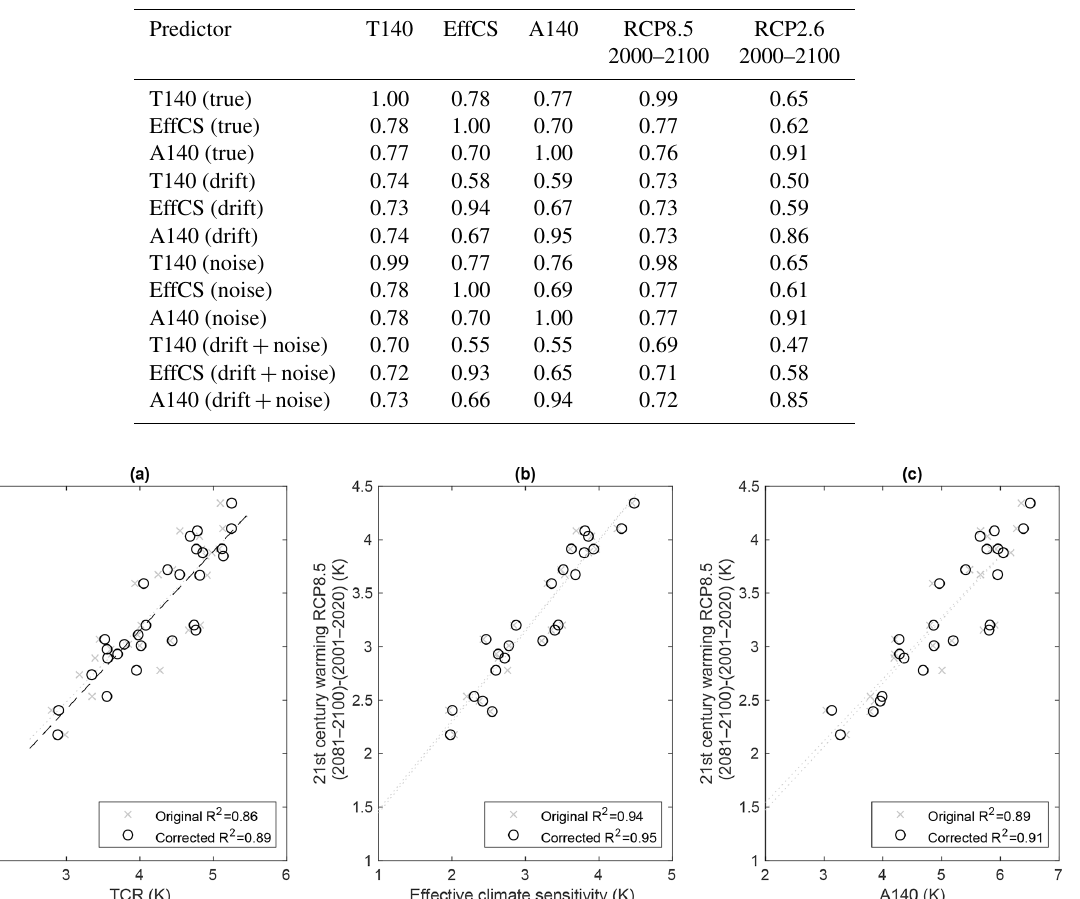
Table 2. A table showing R 2 regression statistics relating a set of predictors to a set of unbiased model properties. Predictors are tran- sient climate sensitivity at quadrupling of CO 2 (T140), effective climate sensitivity (EffCS) and warming 140 years after a quadrupling of CO 2 (A140); additional rows show these values measured experiments conducted with non-equilibrated base climates (drift), additive au- toregressive noise (noise) and a combination of both factors (drift plus noise). “True” output model properties (T140, EffCS, A140, RCP8.5 and RCP2.6 warming from 2000 to 2100) are derived from the equilibrated model without noise. Predictor T140